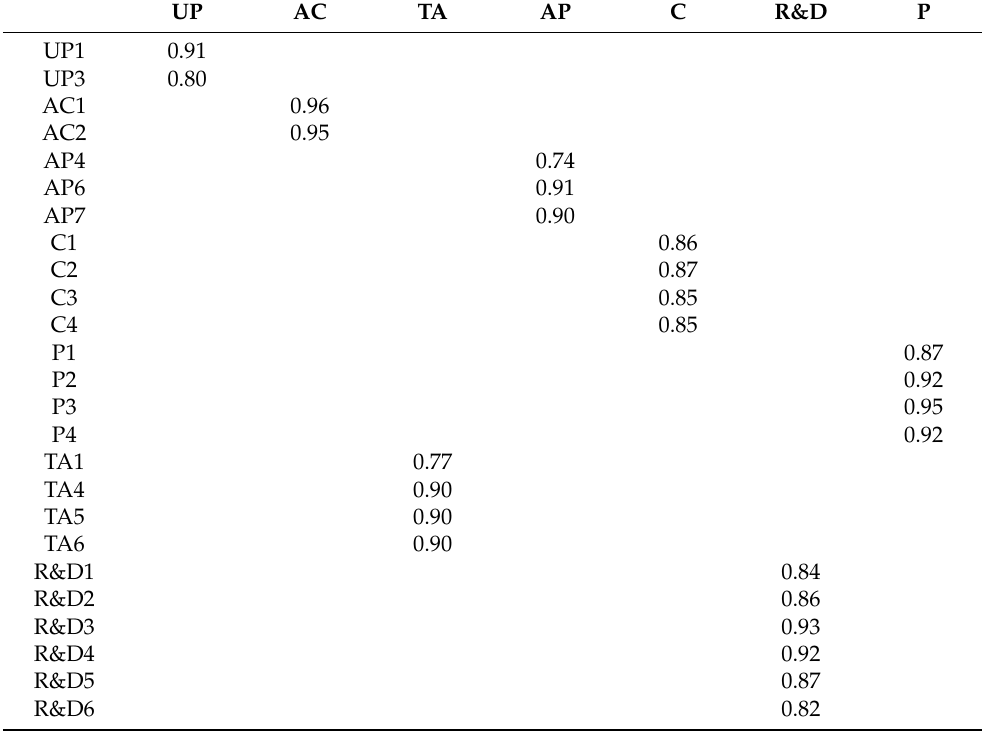
Table 2. Evaluation of